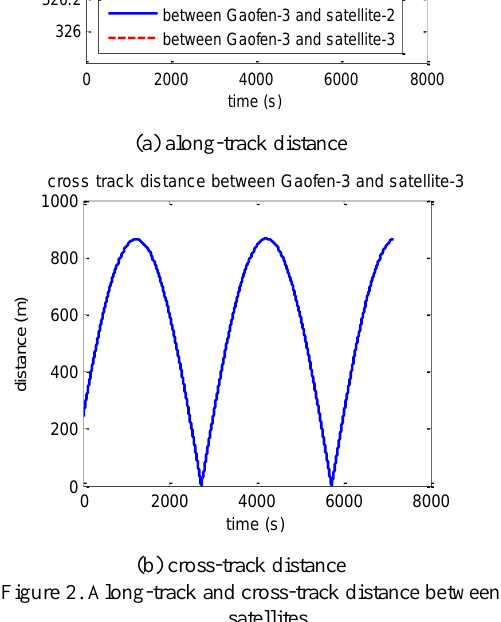
Figure 2. Along-track and cross-track distance between the satellites